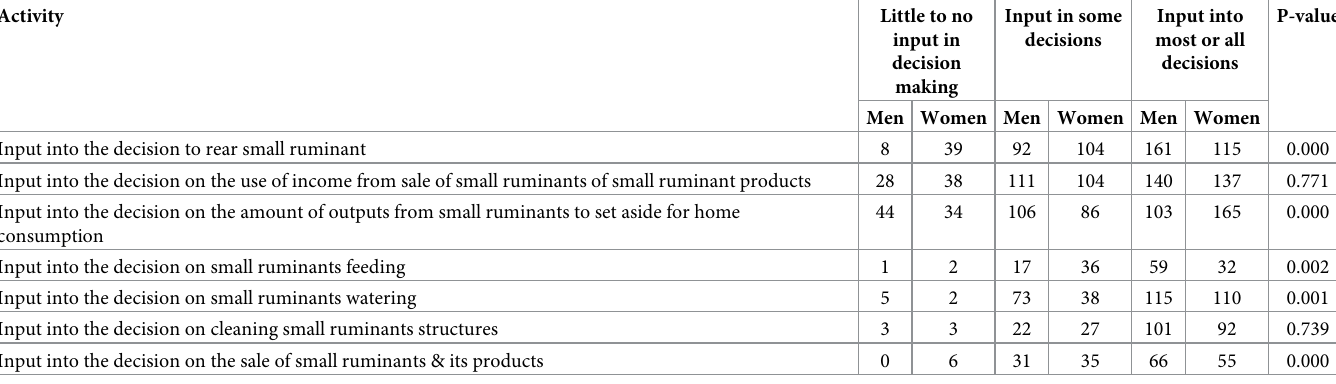
Table 8. Men and women who took part in decision-making on various production